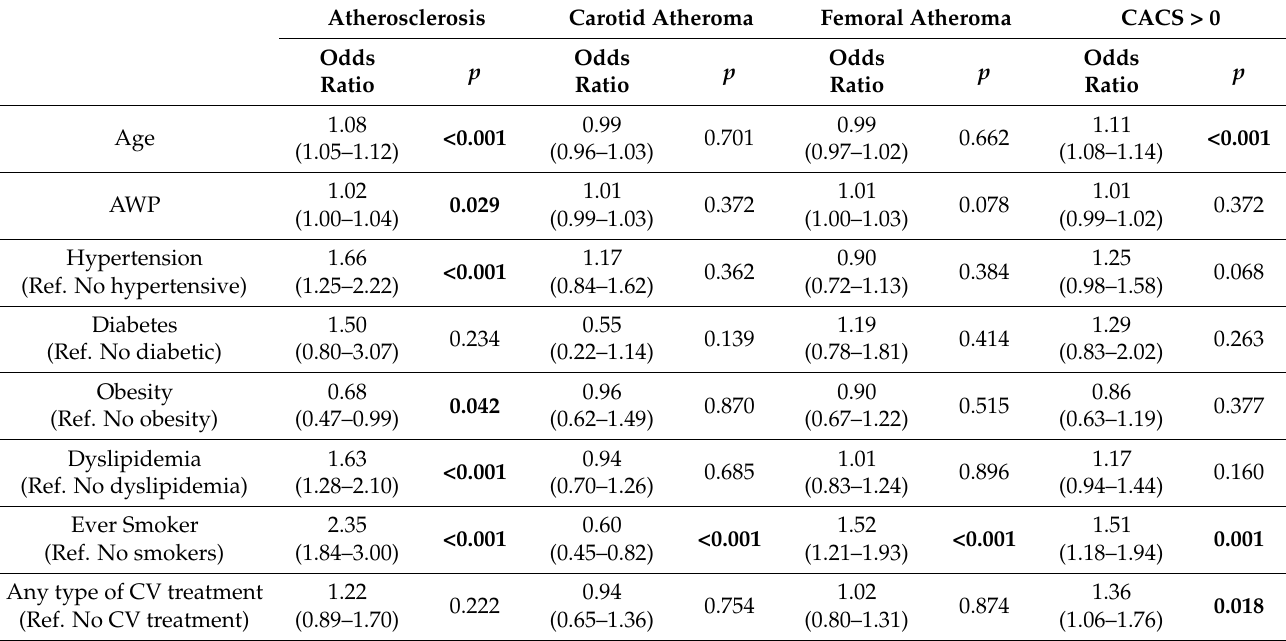
Table 5. Association between any type of cardiovascular treatment and the presence of subclinical atherosclerosis, adjusted by cardiovascular risk factors.